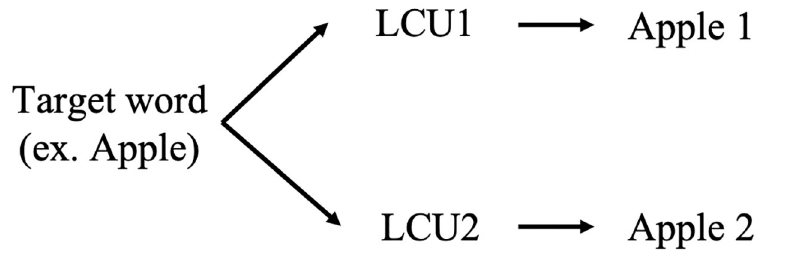
Fig 2. Context unit